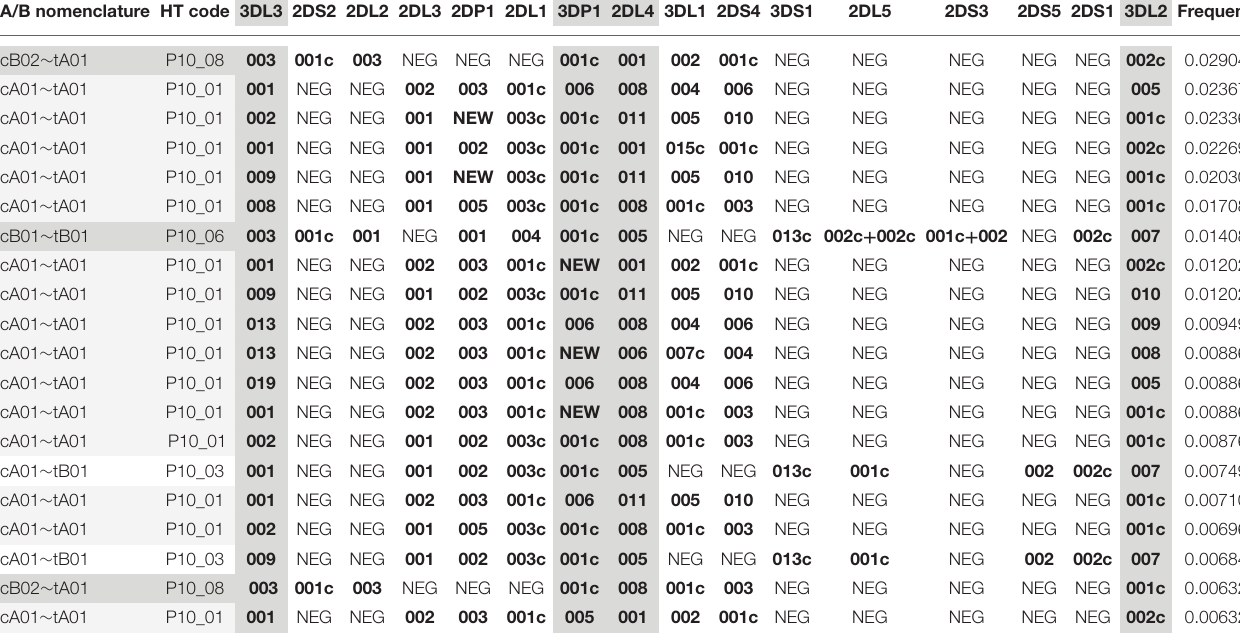
TABLE 1 | Top 20 allele group KIR haplotypes ranked by their respective